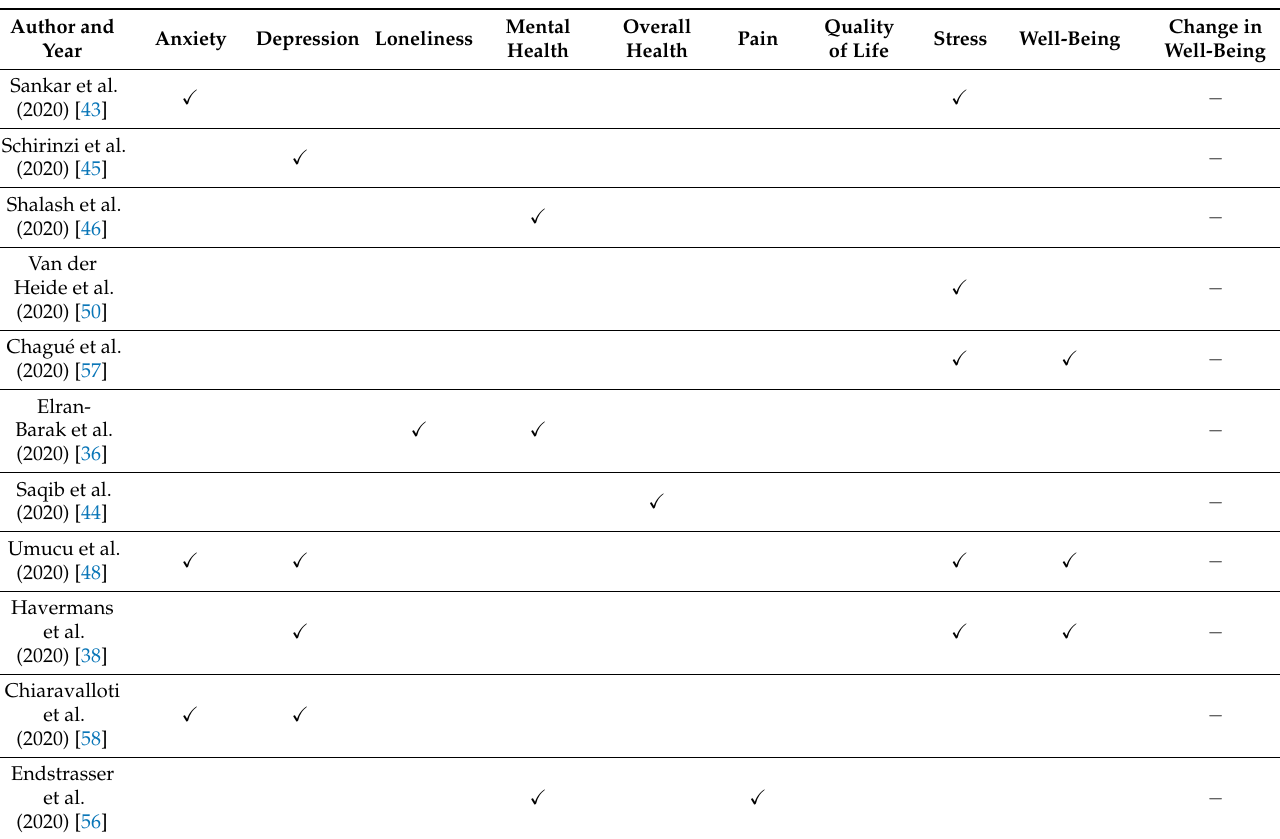
Table 6. Different well-being constructs used in the included